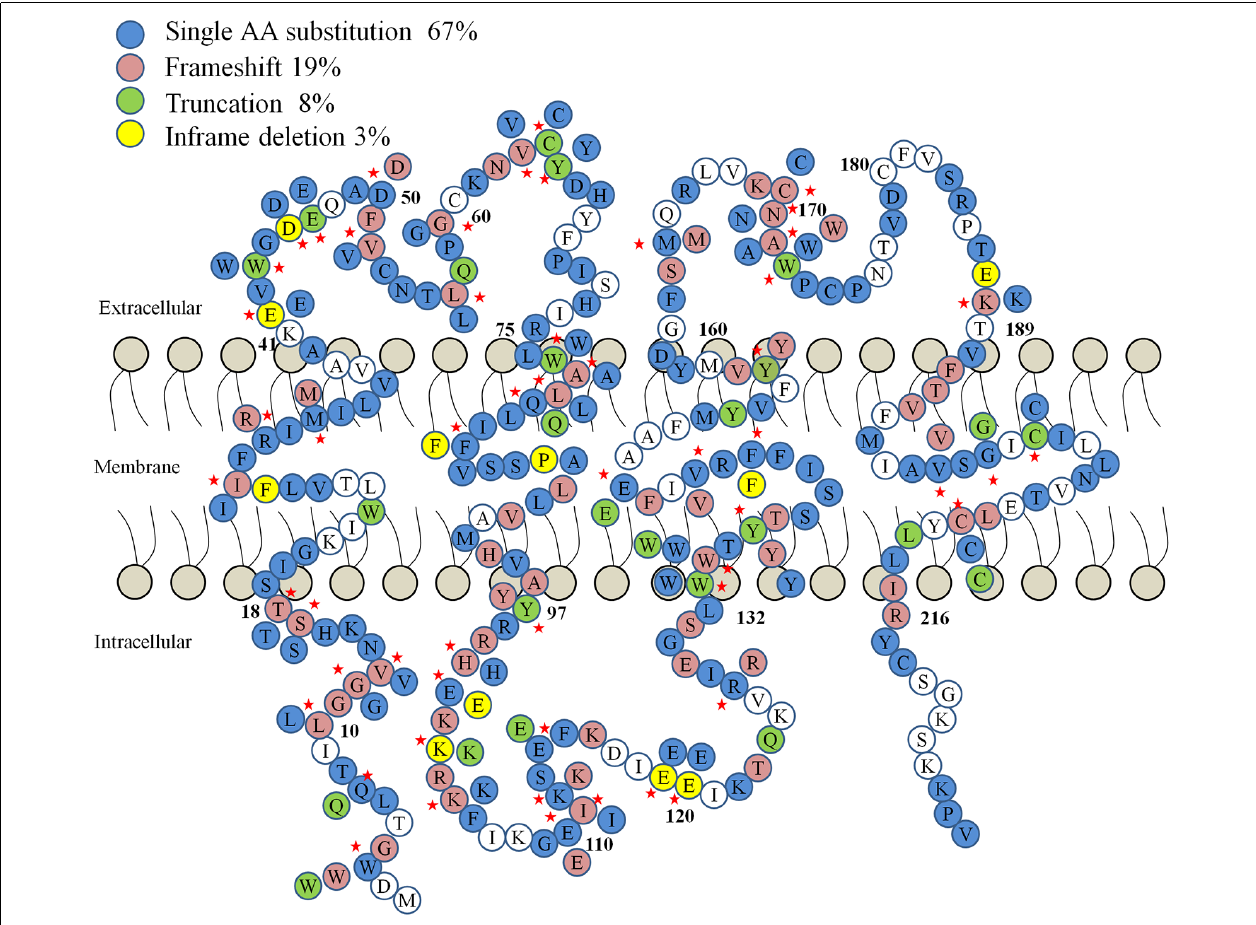
FIGURE 1 | A diagram of human Connexin 26 (Cx26) protein mutations linked to hearing loss. The four types of mutations (frame shift, truncation, single amino acid substitution and in-frame deletion) are color-coded. Red stars denote residues with more than one type of